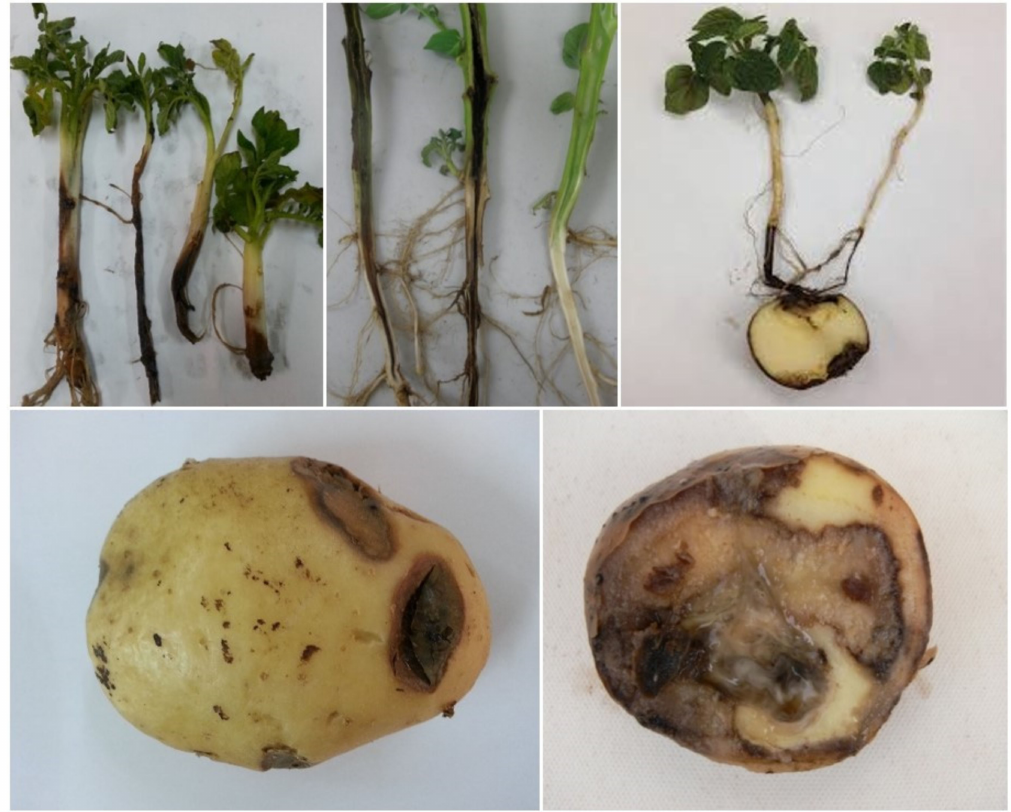
Figure 1. Damage induced by P. atrosepticum on seed tuber and stem of